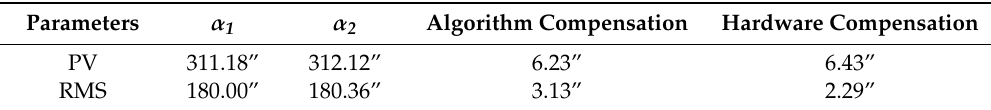
Table 3. Accuracy